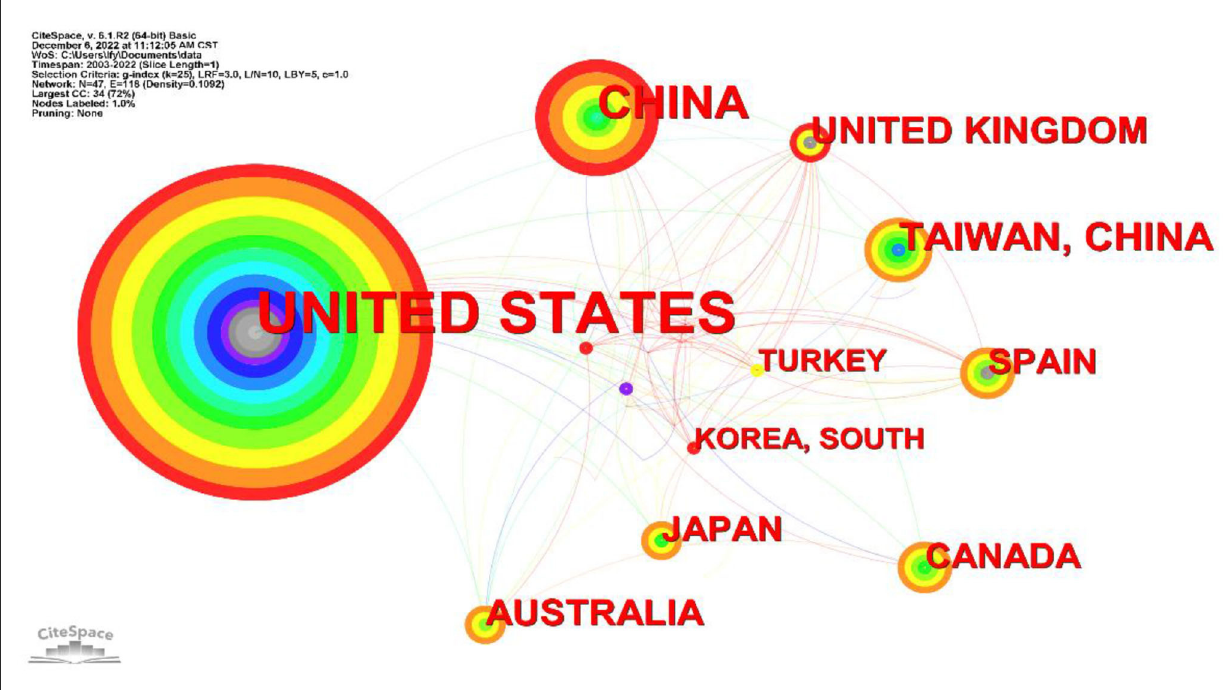
FIGURE3 Country/region collaboration chart.